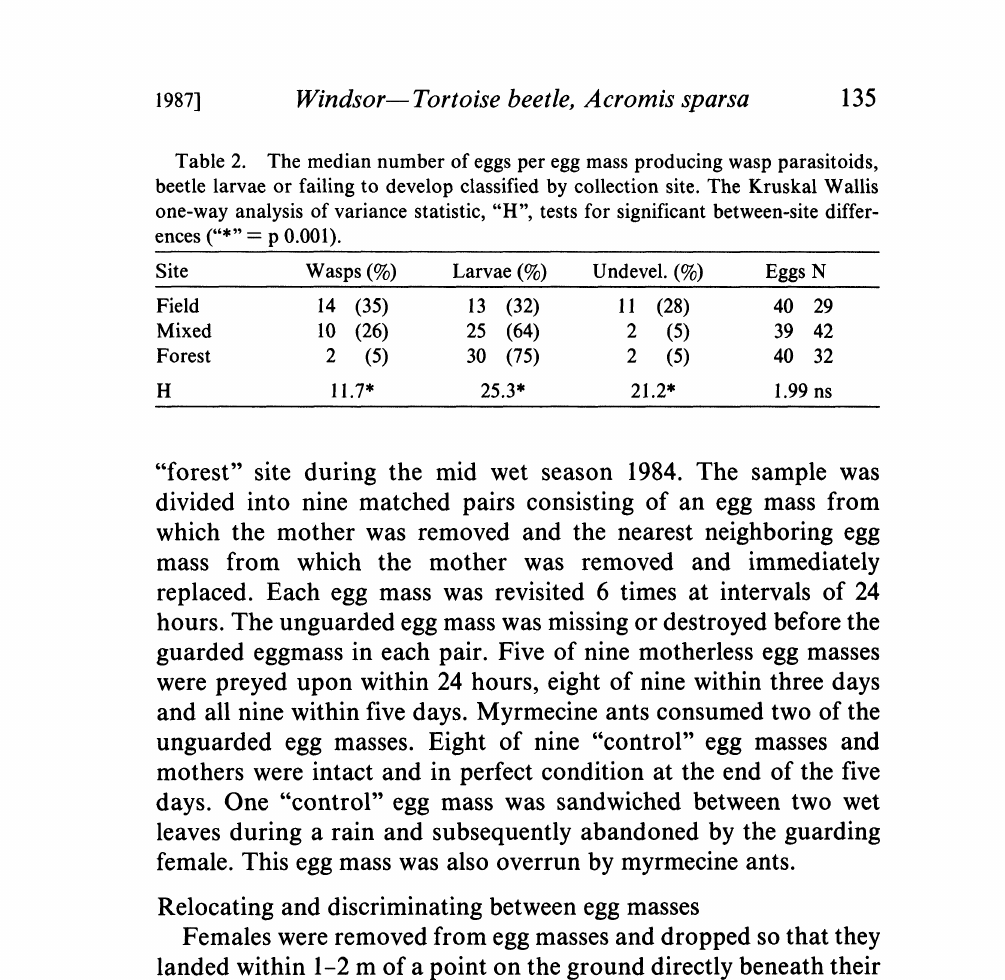
Table 2. The median number of eggs per egg mass producing wasp parasitoids, beetle larvae or failing to develop classified by collection site. The Kruskal Wallis one-way analysis of variance statistic, "H", tests for significant between-site differ- ences ("*" p